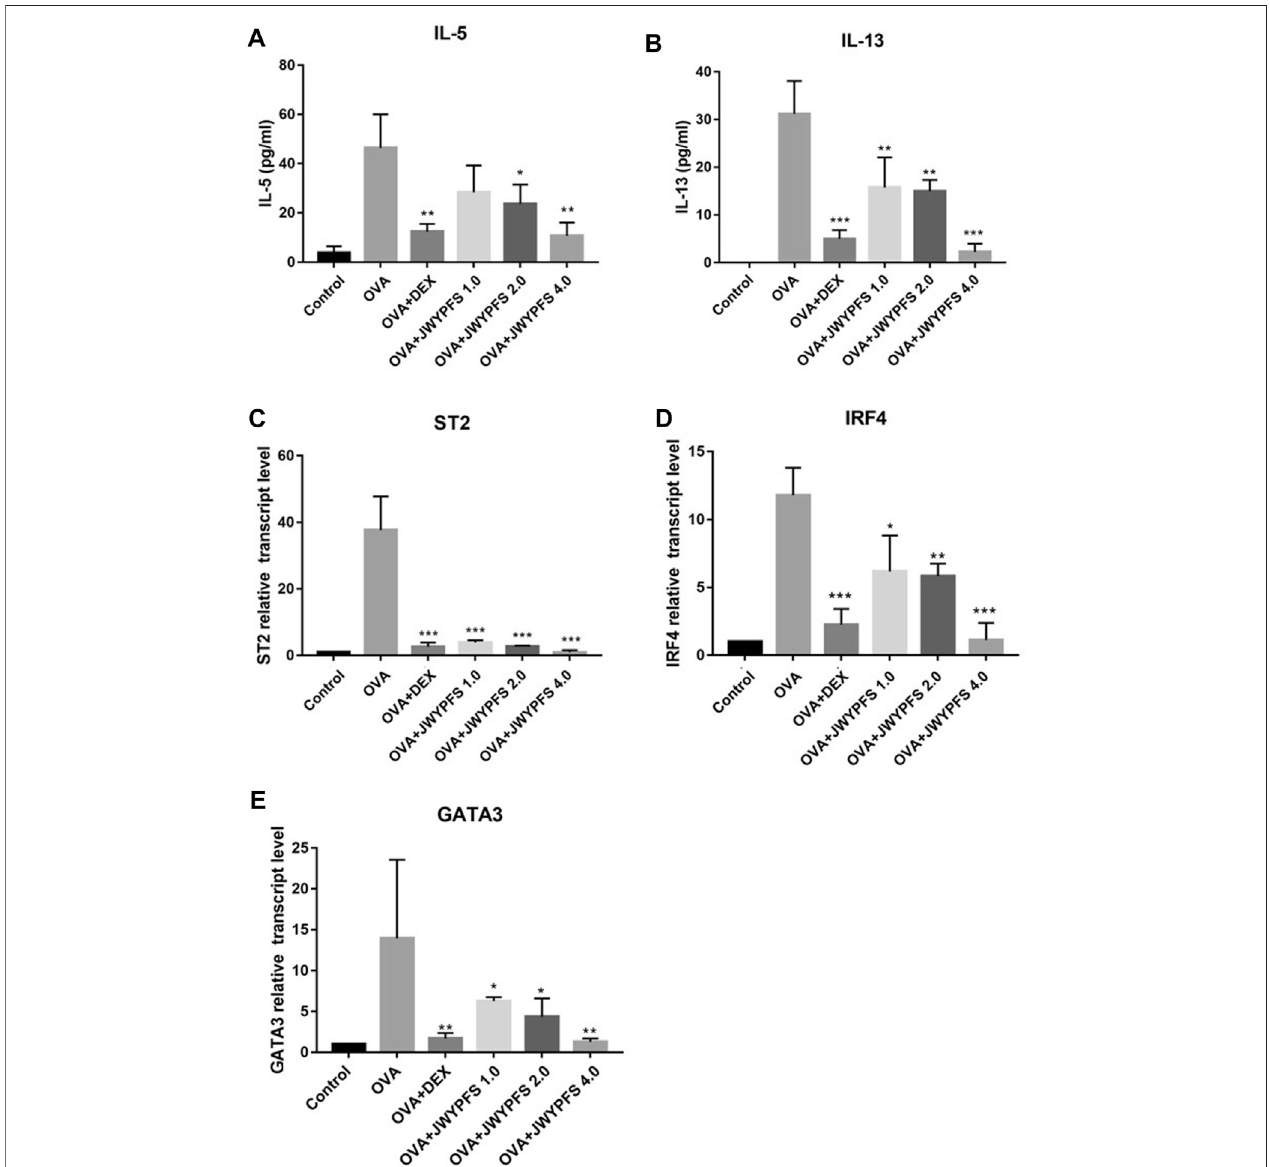
FIGURE5| TheeffectofJWYPFS onILC2scytokine expression and related transcriptionfactors in thelung. (A) The level ofIL-5 inthelung byELISA. (B) Thelevel of IL-13 inthe lung by ELISA. (C) Relative expression ofST2mRNA inlung. (D) IRF4 mRNA expression in lung. (E) GATA3mRNA expression in lung. Data are shown as mean ± SD. * p < 0.05, ** p < 0.01, *** p < 0.001, compared with OVA group.